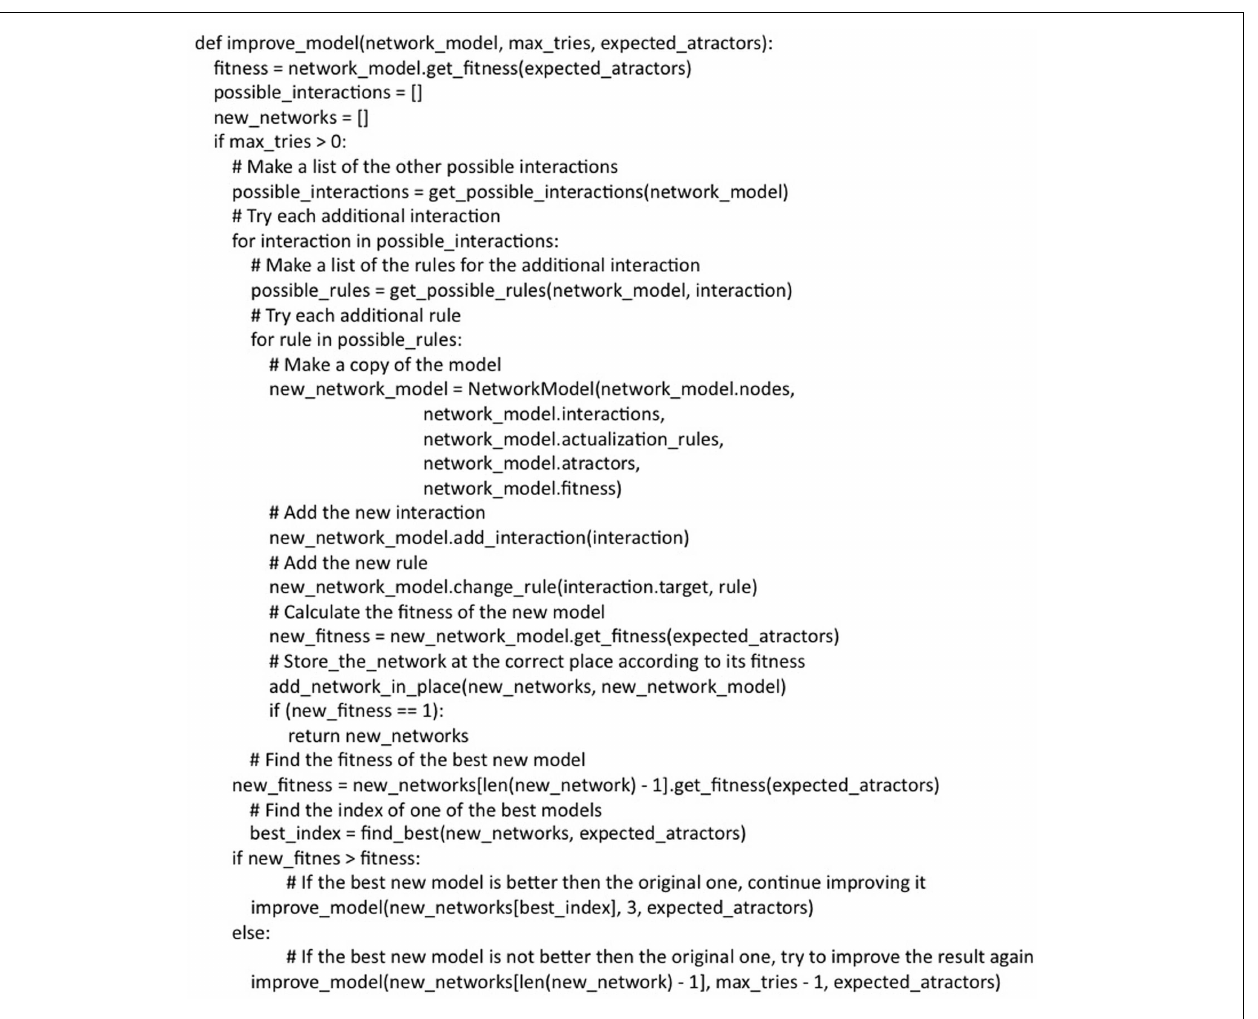
FIGURE 5 | Pseudocode of the methodology used to incorporate putative missing interactions